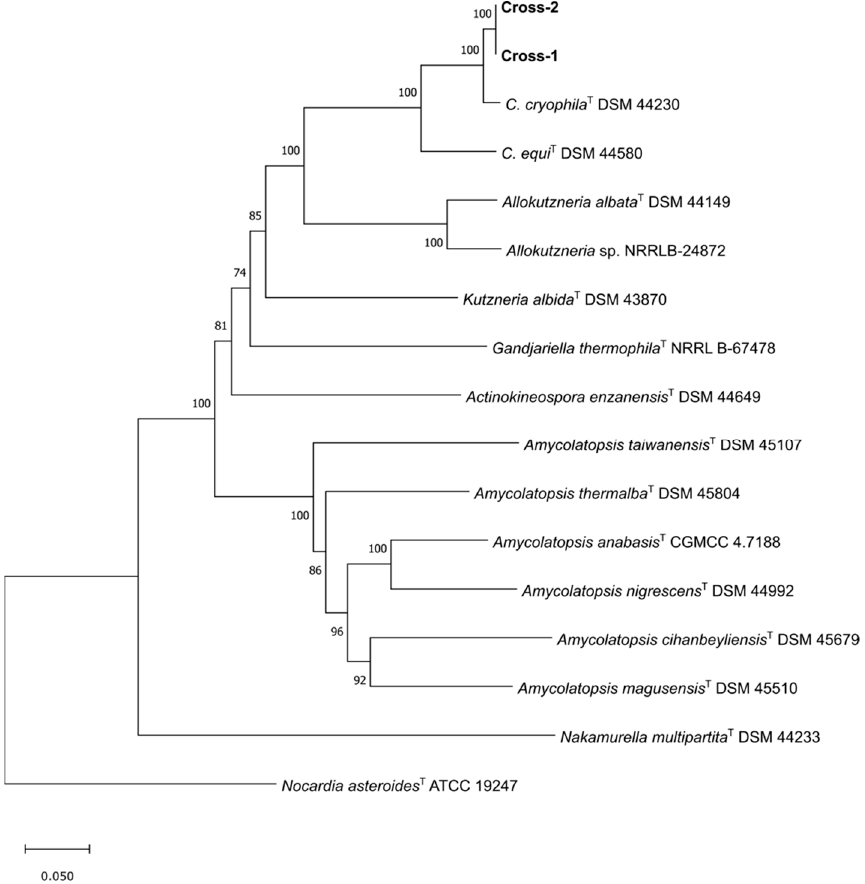
Figure 4. Maximum-likelihood phylogenetic tree based on 71 single-genes sequences showing the relationship of strains Cross-1 and Cross-2 with related species belonging to the family Pseudono- cardiaceae . The bootstrap consensus tree inferred from 1000 replicates is taken to represent the evolutionary history of the taxa analyzed. There were a total of 45,445 positions in the final dataset. The genome of Nocardia asteroides ATCC 19247 T was used as outgroup. Bar, 0.05 substitutions per nucleotide position.